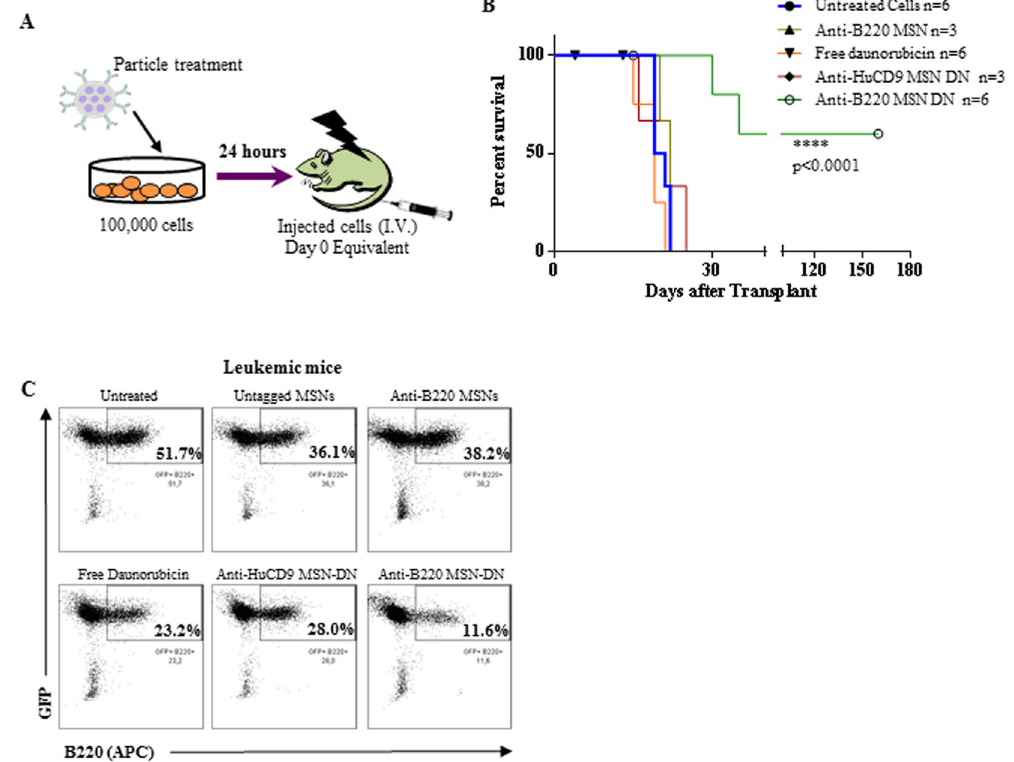
Figure 3. ( A ) Schematic diagram of the experimental set up of the experiments testing the impact of MSNs on the leukemia repopulating activity of B220 + AML cells. ( B ) Survival curve of mice transplanted with the day 0 equivalent of 1 × 10 5 B220 + AML LSCs after 24 hours treatment with the different MSNs particles as indicated. Mice numbers originating from two independent experiments are shown (p < 0.0001). 3 of 6 mice treated with the anti-B220 MSN-DN particles stayed healthy until day 160 post-transplant (see Supplementary Fig. S4). ( C ) Dot plots of BM of representative mice succumbing to leukemia in the different experimental arms showing lowest proportion of LSCs (GFP + B220 + ) for the anti-B220 MSN-DN treatment